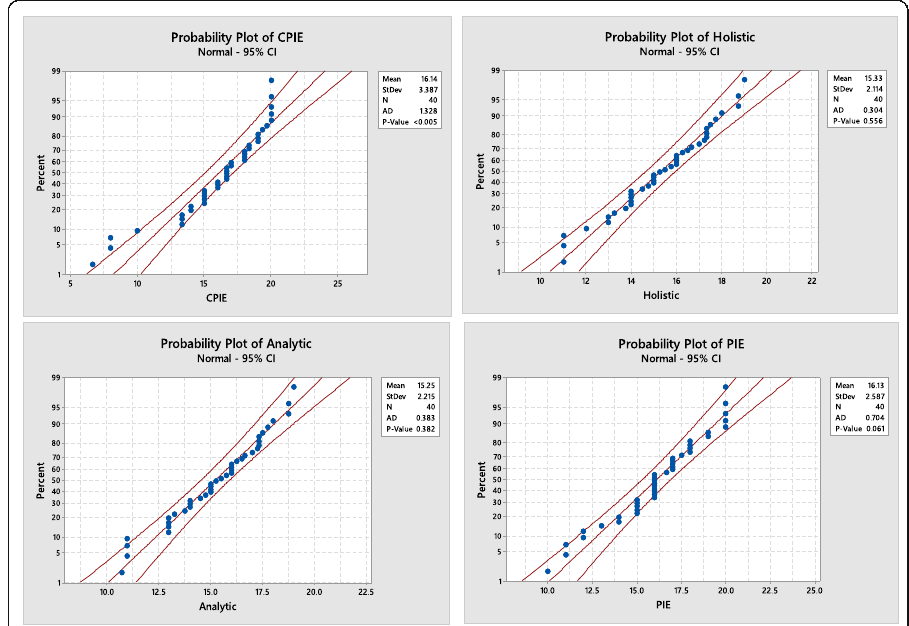
Fig. 2 Probability plot of the validity of evaluation methods (Minitab 2017). The p value of the figures showed a significant difference in favor of the CPIE method. The p values for the PIE, analytic, and holistic methods were 0.061, 0.382, and 0.556, respectively, which were greater than